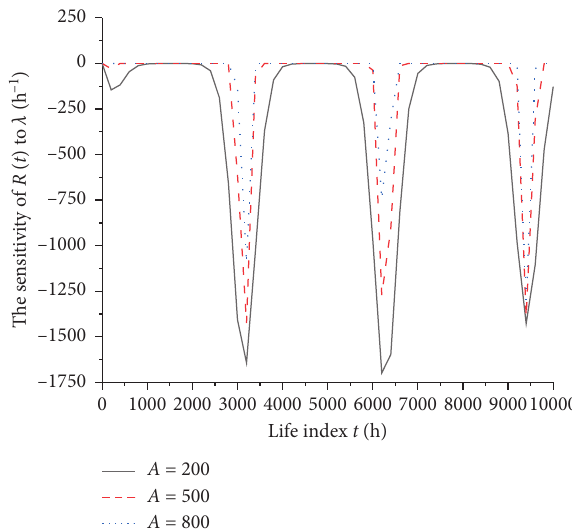
Figure 26: The sensitivity of R ( t ) to λ ( A � 200/500/800).